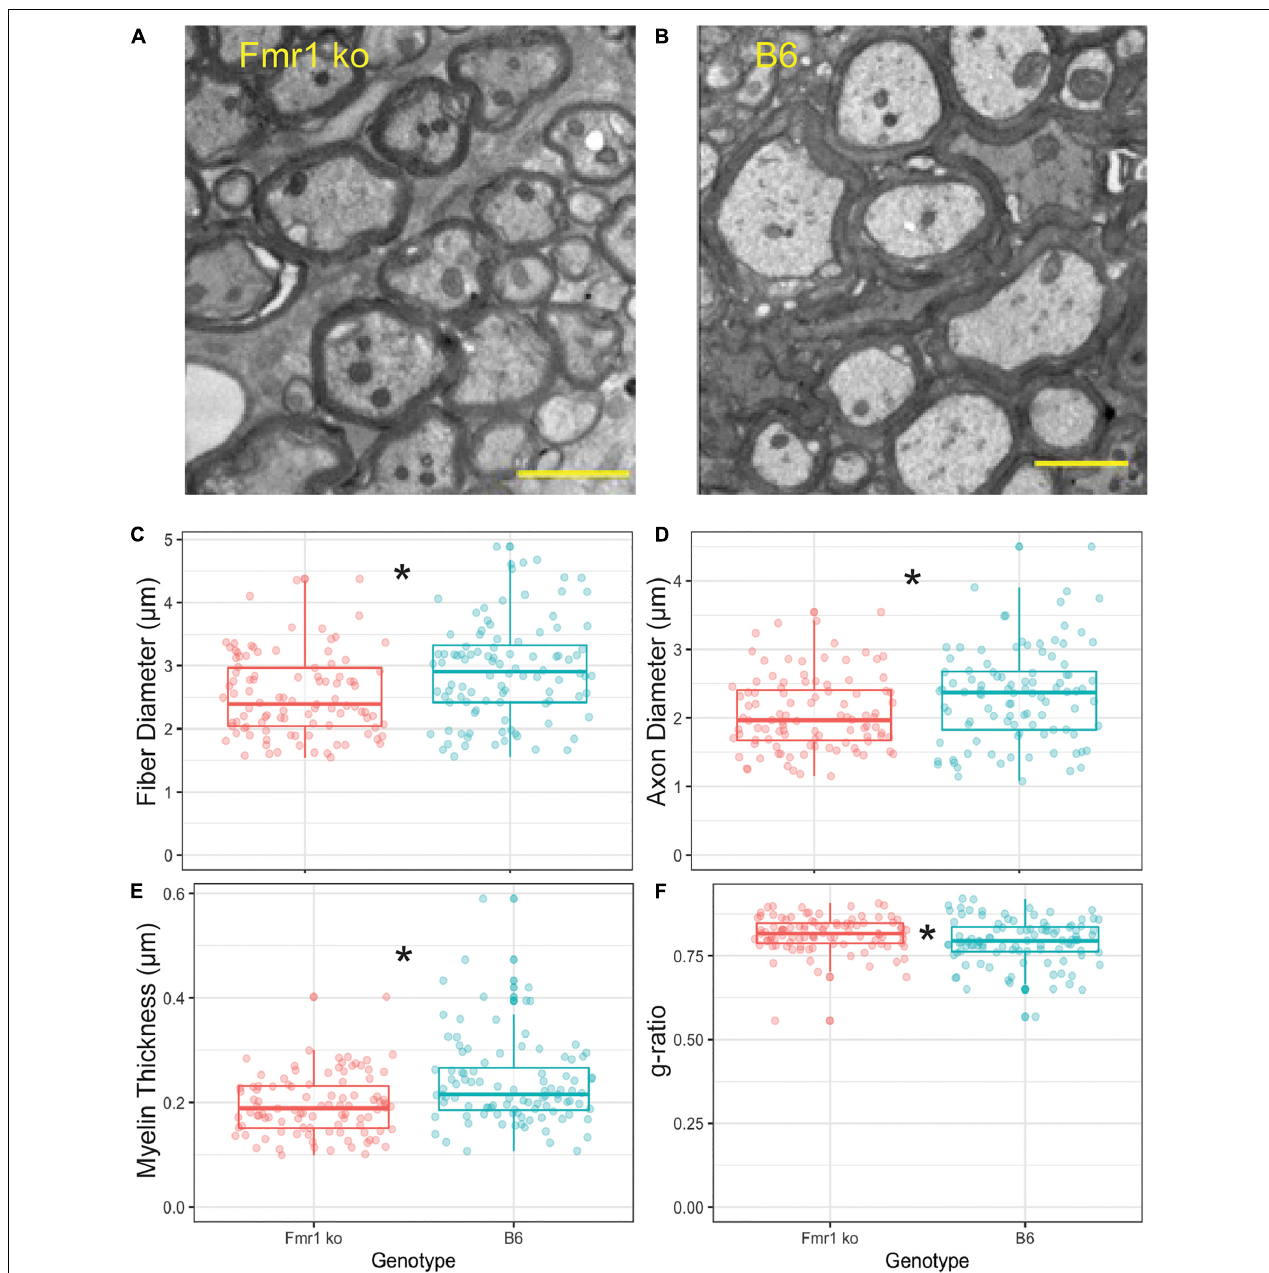
FIGURE 4 | Myelin characteristics are also altered in Fmr1 KO compared to B6 mice measured by EM. Representative images for EM in Fmr1 KO (A) and B6 (B) mice. Scale bar is 2 µ m. Box plots show data from each individual measurement for Fmr1 KO (left) and B6 (right) mice. Measured parameters include fiber diameter (C) , axon diameter (D) , myelin thickness (E) , and g-ratio (F) . N is one animal per genotype with multiple sections and multiple measurements/section represented by individual puncta. * p <